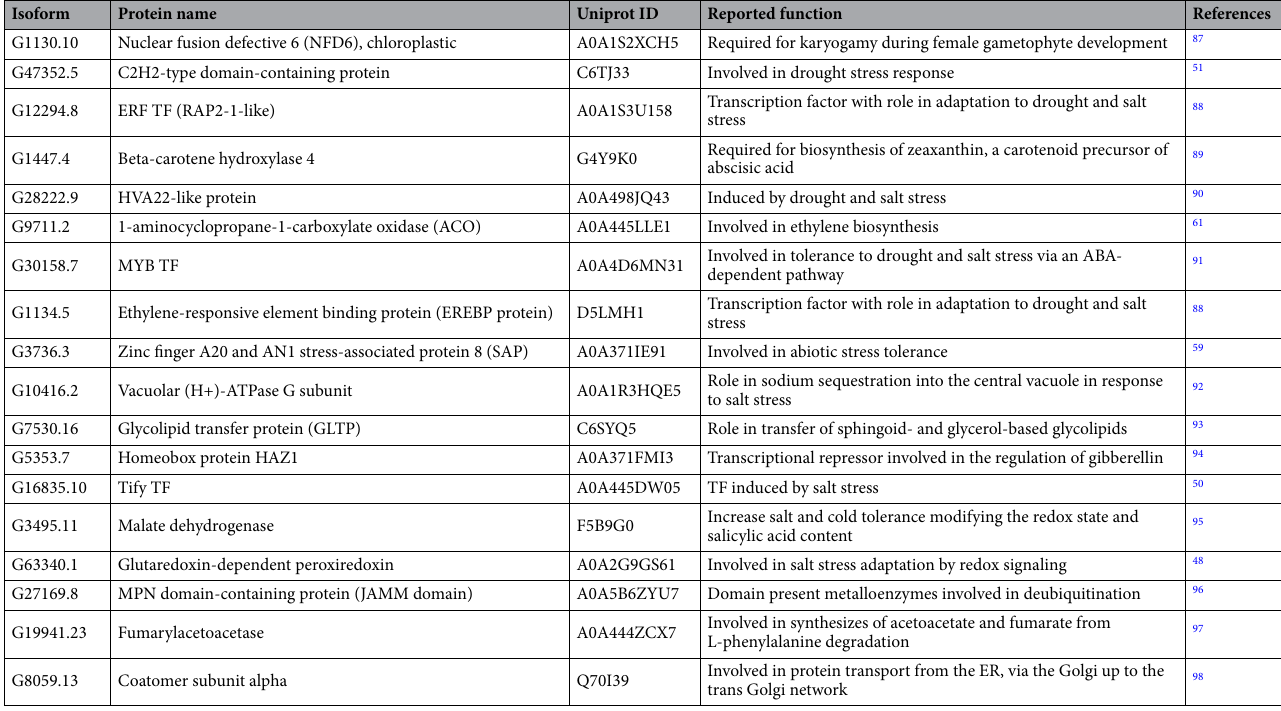
Table 1. Master genes identified in alfalfa pan-transcriptome by weighed gene co-expression network